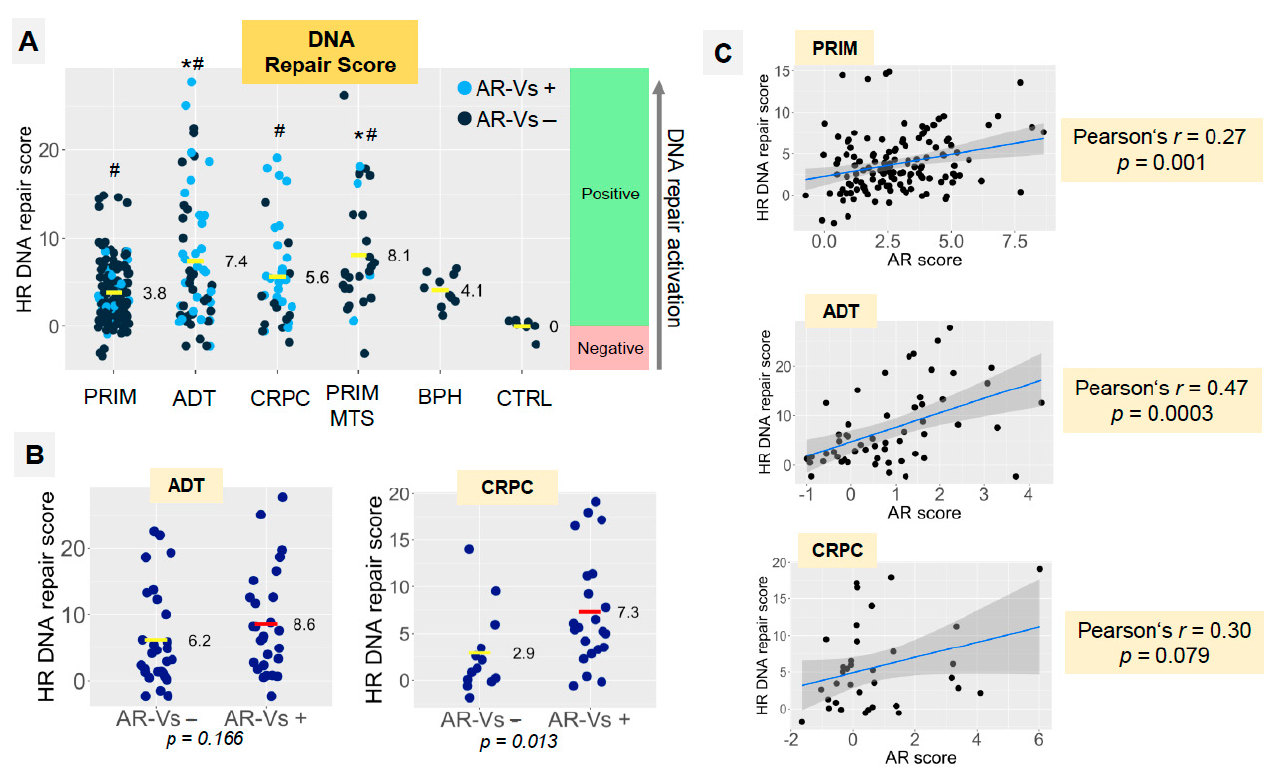
11 of 21 Figure 5. Heatmap plot of mRNA expression levels of DNA repair genes and AR-V splice variants as a quantitative parameter ( left side ). Samples represent pooled tumor samples from ADT and CRPC groups. Note similarities in the expression levels of the upper cluster of DNA repair genes (RAD51 to BRCA2) and AR-V splice variants, with the exception of 15 samples on the left side (mostly ADT samples). Clusters are separated by yellow lines. To quantify DNA repair gene expression, we calculated a DNA repair activity score (DNA-R score) from the expression levels of 20 genes (excluding PARP1 and PARP2 ) using CTRL samples as a reference, analogous to the AR score introduced above (Figures 6 and S3). The DNA-R score significantly increased in all groups, including BPH, compared to the reference group (Figure 6A). In the presence of AR-Vs, the DNA-R score increased significantly in CRPCs. We observed a similar trend in the ADT group (Figure 6B). In the PRIM and ADT groups, as well as in the CRPC group (statistical trend), the DNA-R score significantly correlated with the AR score (Figure 6C). In linear regression models, the effect of proliferation on DNA repair was clearly visible (Table 2, lower panel). However when accounting for this effect, residual coefficient estimates revealed a positive